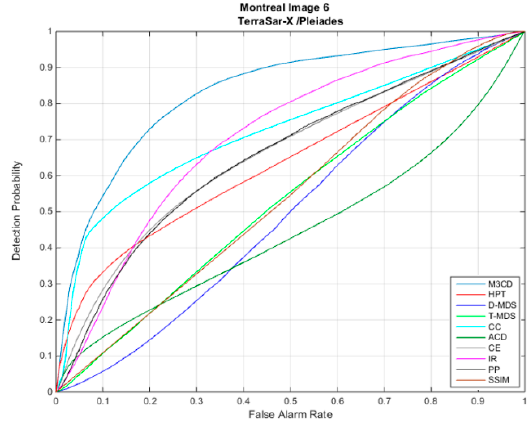
Figure 14. Image pair-4: TerraSAR-X/Pleiades.